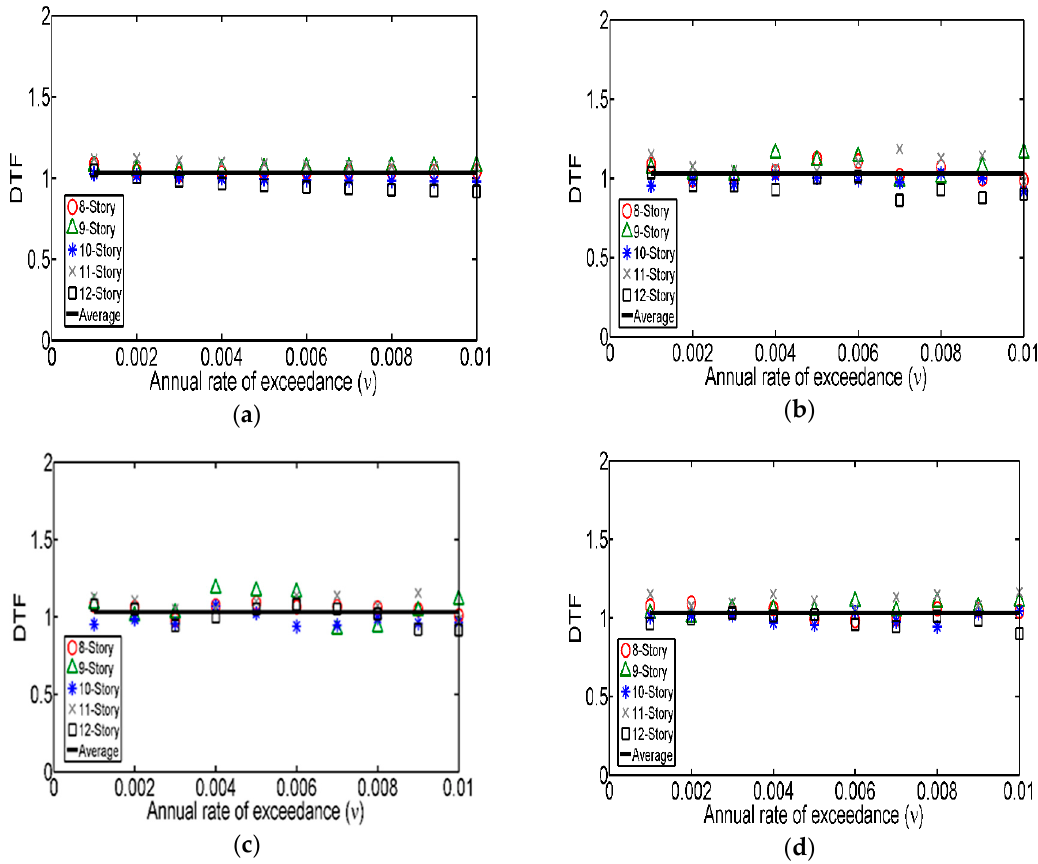
Figure 12. Ductility transformation factors between simplified systems (SS) and multi-degree of freedom (MDOF) systems for different values of α . ( a ) Symmetric; ( b ) α = 0.01; ( c ) α = 0.02; ( d ) α = 0.03.